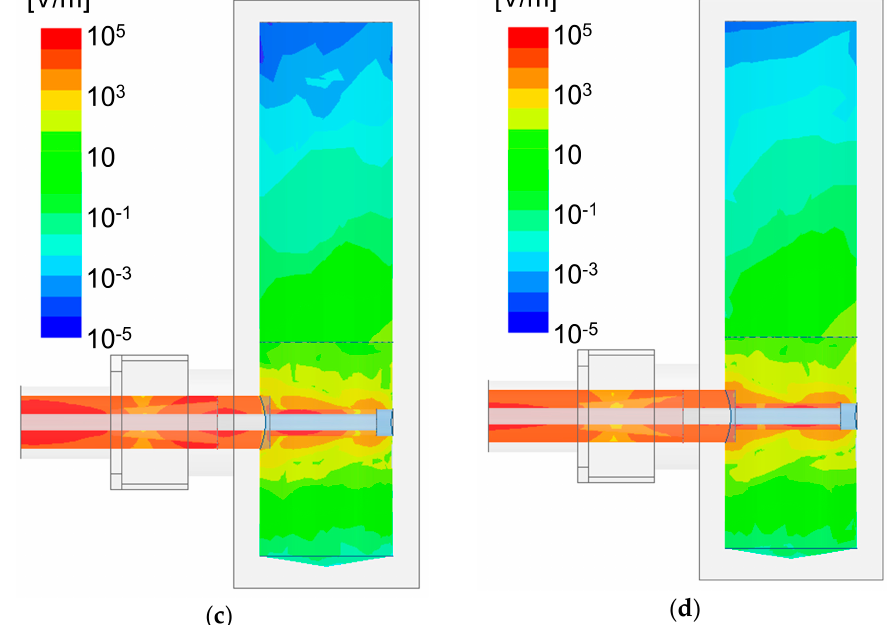
Figure 7. Simulated electric field distribution in the cylindrical applicator using liquid samples of water at ( a ) 2.45 GHz and ( b ) 1.7 GHz, and a NaOH solution at ( c ) 2.45 GHz and ( d ) 1.7 GHz.